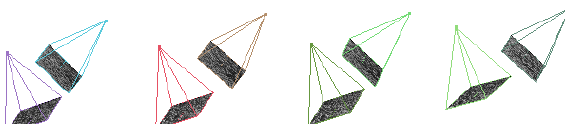
Figure 5. Example of oblique image exterior orientations from two flight